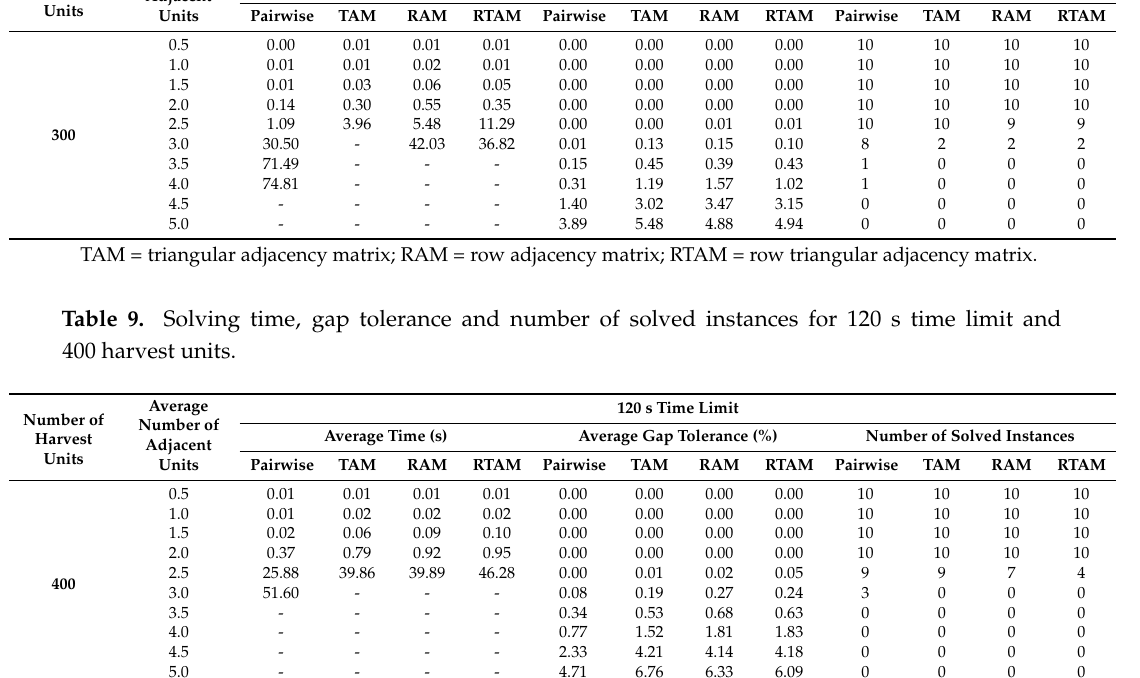
Table 10. Solving time, gap tolerance and number of solved instances for 120 s time limit and 500 harvest units. Average Number of Number of Harvest Adjacent Units